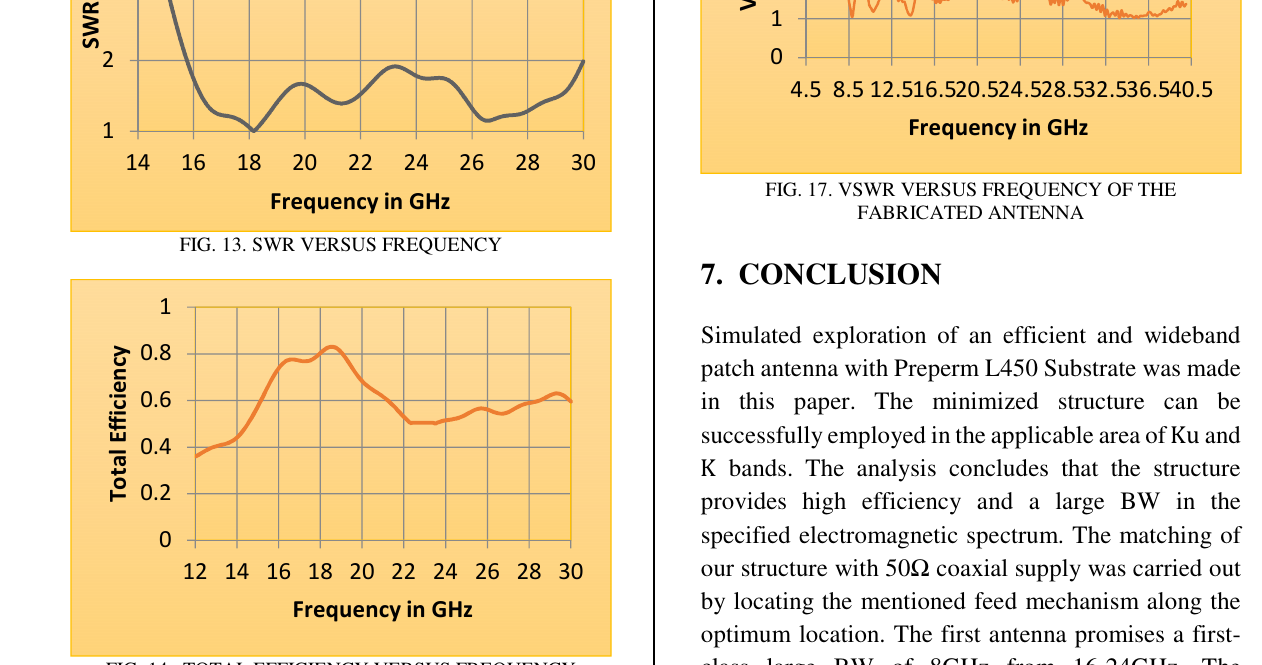
FIG. 14. TOTAL EFFICIENCY VERSUS FREQUENCY